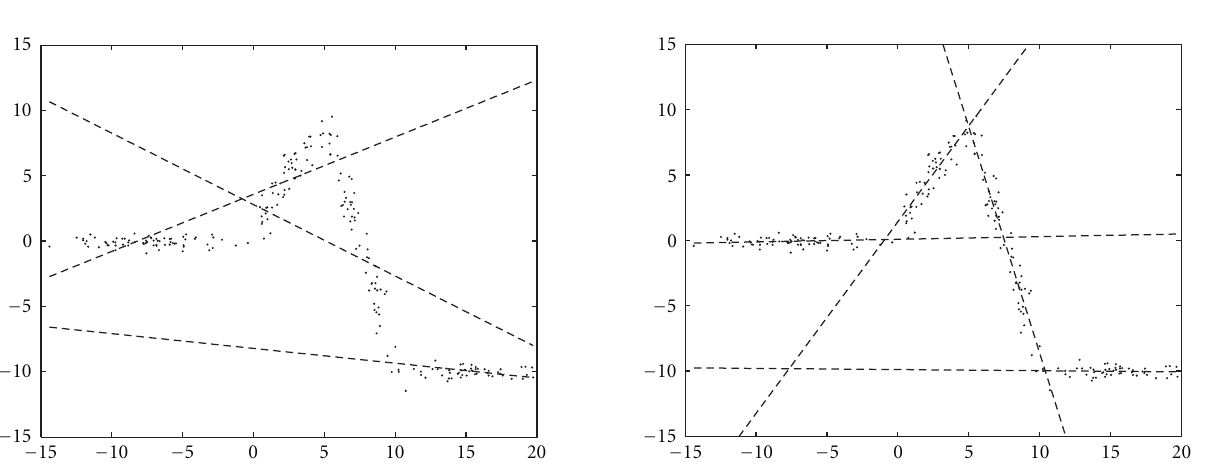
Figure 9: Final hyperplanes (dashed lines) estimated by the hyper- plane clustering in the case M = 4.